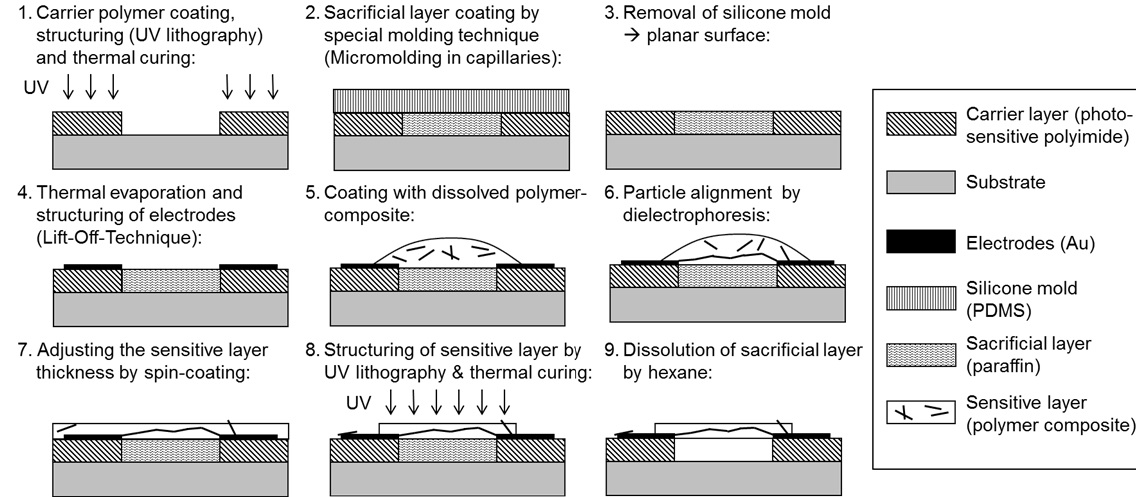
Figure 3. Schematic portrayal of the individual process steps for the manufacture of microbolometer arrays under principal use of polymeric materials and technologies; UV – ultraviolet, PDMS – polydimethylsiloxane.